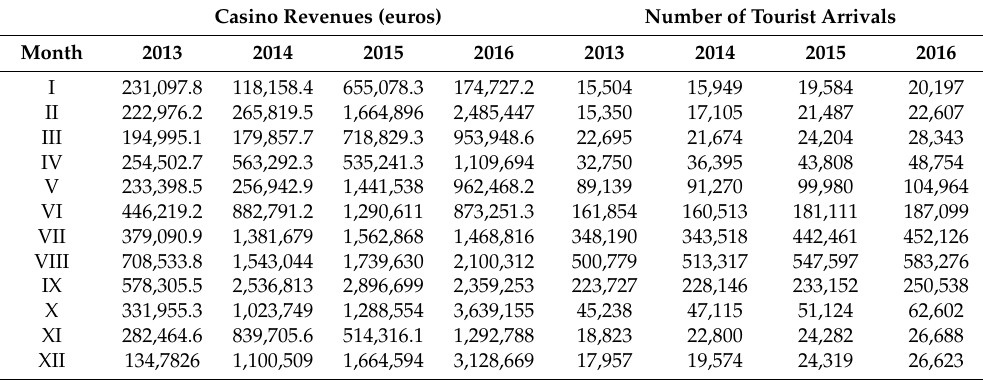
Table 1. Input information for econometric analysis of casinos and tourism in Montenegro—Sample.